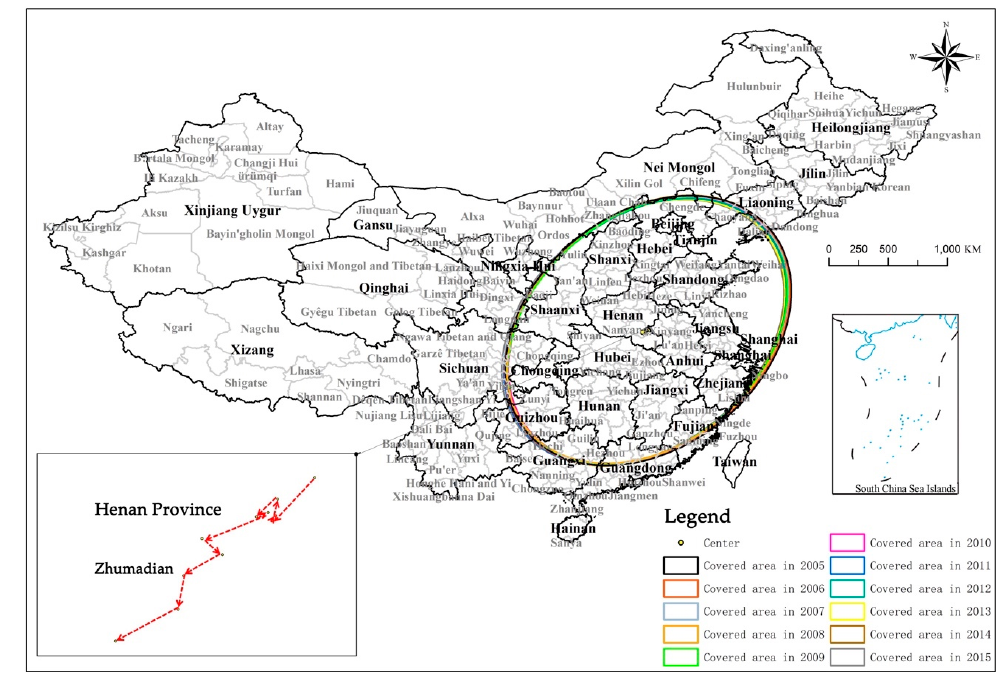
Figure 7. Evolution of the spatial distribution center and scope of urbanization coordination level in China from 2005 to 2015.